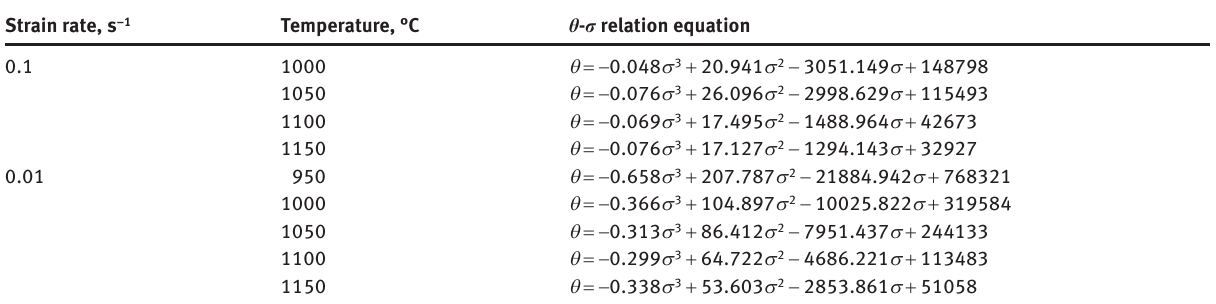
Table 1: Coefficients for work hardening rate ( θ ) versus stress ( σ ) equations of AISI 420 stainless steel. Strain rate, s −1